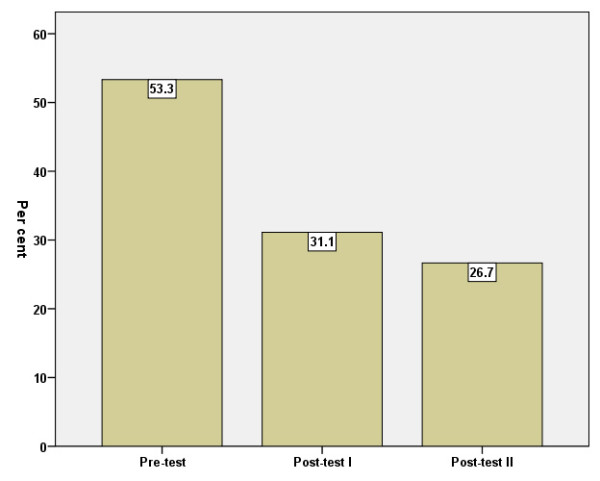
Perceived own health as worse than coevals', per cent, before = baseline (I), immediately after (II) and three months after (III) the intervention. Error Bars: +/- 1.96 SE.